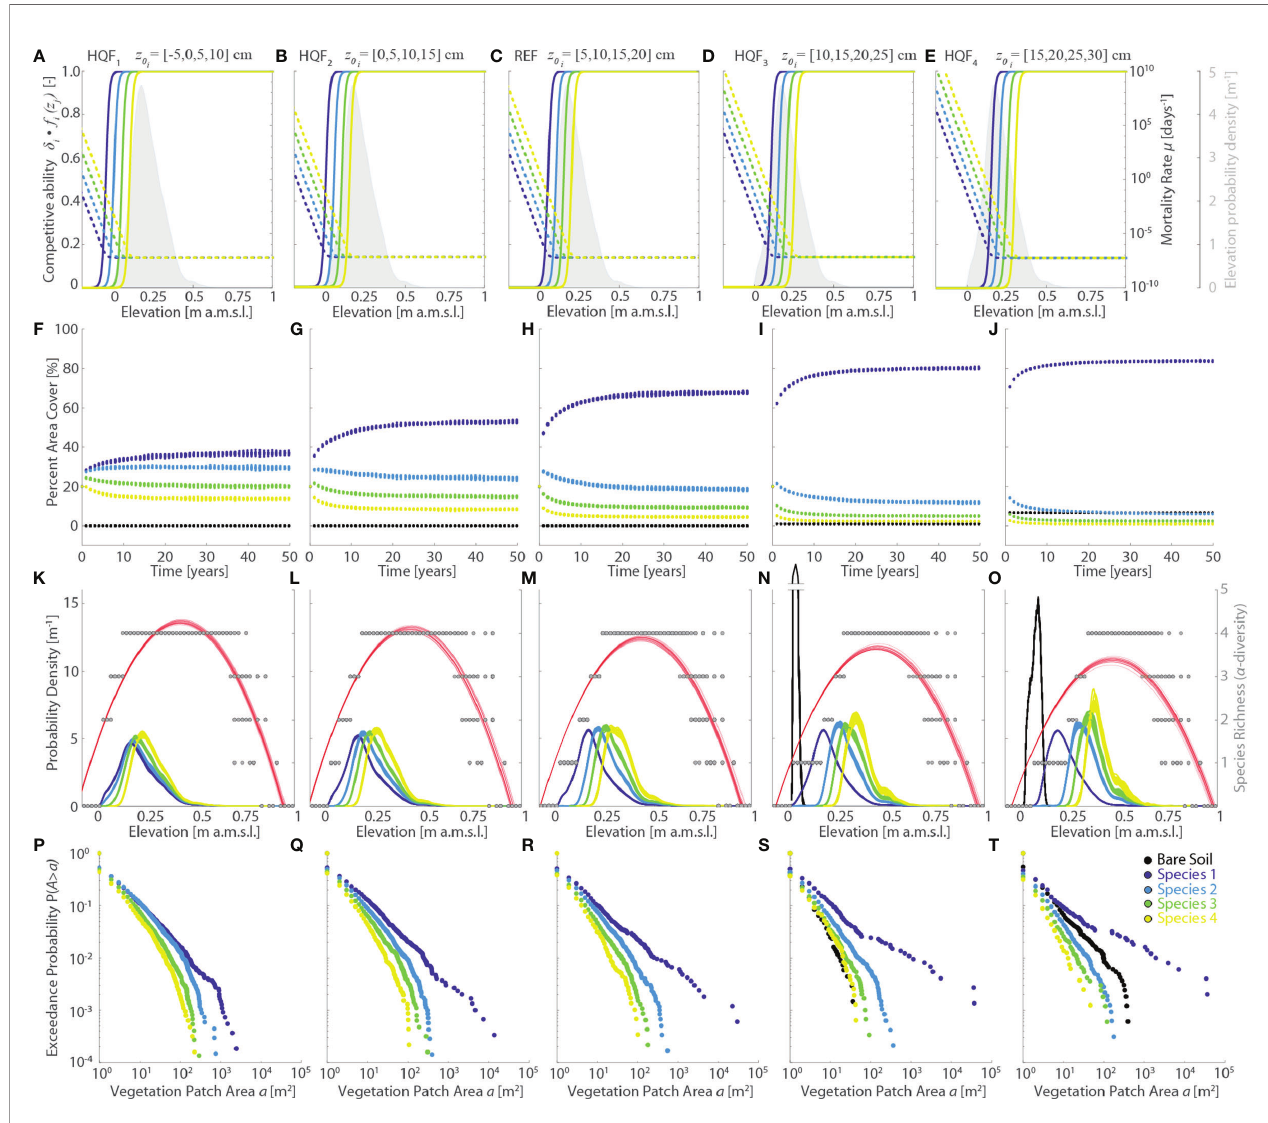
FIGURE 4 | Effects of changes in the vegetation habitat quality functions (HQF series, varying logistic sigmoid point z 0 ). Results of the reference simulation (REF, z 0 = {5,10,15,20} cm) are shown in the central column. The fi rst and second columns report respectively the results of the HQF 1 (z 0 ={-5,0,5,10} cm) and HQF 2 (z 0 = {0,5,10,15} cm) simulations, whereas the fourth and fi fth columns show the results of the HQF 4 (z 0 ={10,15,20,25} cm) and HQF 5 (z 0 ={15,20,25,30} cm) simulations, respectively. Each panel displays data derived from all the 20 numerical simulations performed for each scenario. Different colors denote different vegetation species, including bare soil, according to the legend shown in the lower-right panel. (A – E) Patterns of speci fi c competitive ability d i f i ( z j ) (continuous lines, left y-axis) and mortality rate µ i ( z j ) (dotted lines, right y-axis) as a function of local marsh elevation ( z j ). The gray area denotes the probability density estimates of marsh elevation within the computational domain. (F – J) Changes of percent vegetation cover over the whole simulation horizon. (K – O) Realized vegetation niches (left y-axis) and local species richness (i.e., a -diversity, right y-axis) as a function of marsh elevation at the end of the simulation horizon. Gray dots represent a -diversity point data with red lines showing the best quadratic fi t to point data. (P – T) Empirical probability distributions of spatially-continuous vegetation patch areas are shown based on the exceedance probability for a given vegetation patch